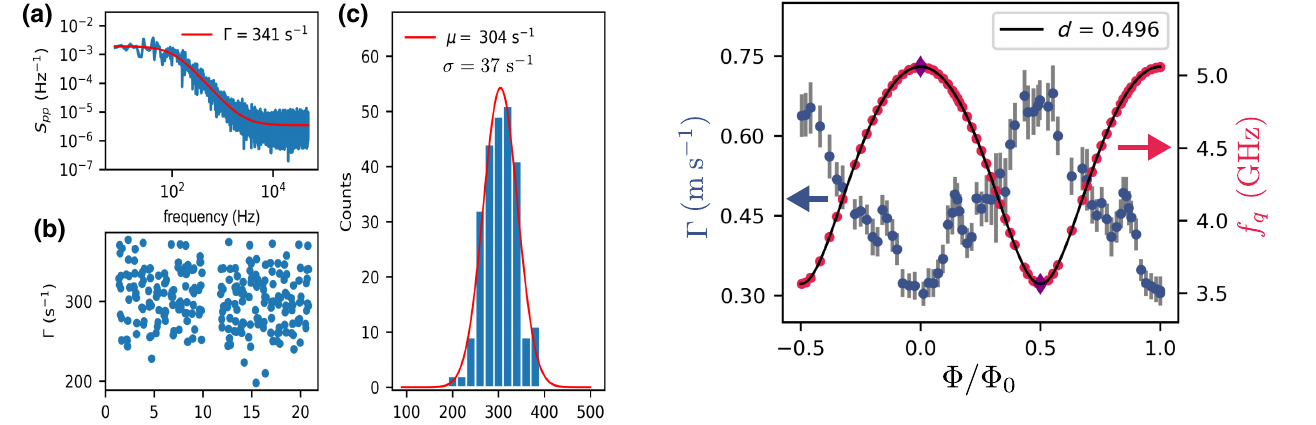
FIG. 8. The charge-parity-switching rate (cid:4) (blue, left axis) and the mean even-odd-parity qubit frequency f q (pink, right axis) as a function of the flux from (cid:5)/(cid:5) 0 = − 0.5 to 1.0. The qubit frequencies at (cid:5)/(cid:5) 0 = 0 and (cid:5)/(cid:5) 0 = 0.5 are taken to be the maximal and minimal qubit frequencies, respectively, and are measured at the beginning of the cool down: f q ,min = 3.5624 GHz, f q ,max = 5.0594 GHz (purple diamonds). The black line shows a fit to just these two data points f q ( 0 ) = 5.0594 GHz and f q ( 0.5 ) = 3.5624 GHz with the expected flux dependence of the frequency f q ((cid:5)) = f q ( 0 )( cos 2 π(cid:5)/(cid:5) 0 + d 2 sin 2 π(cid:5)/(cid:5) 0 ) 1 / 4 , where d = ( E J 1 − E J 2 )/( E J 1 + E J 2 ) . The rest of the measure- ments are assigned flux values based on the qubit frequency according to this